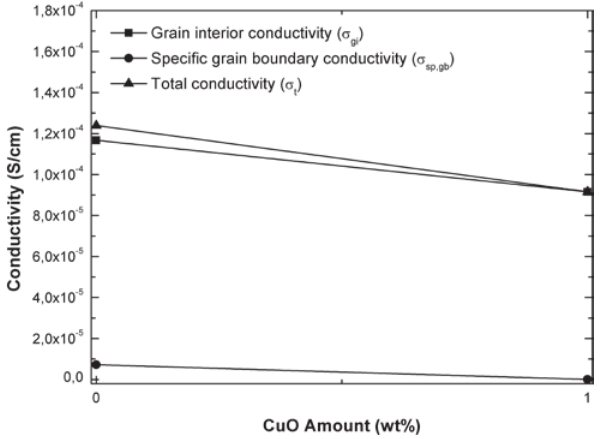
Fig. 6: The effect of addition of CuO on the conductivity of 8YSZ at 400 °C.